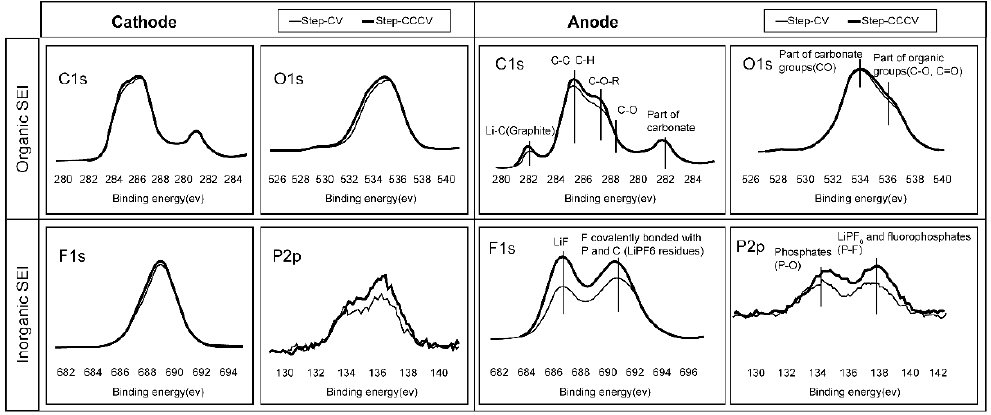
Figure 12. The x-ray photoelectron spectroscopy results of the electrodes from the disassembled 3.3 Ah